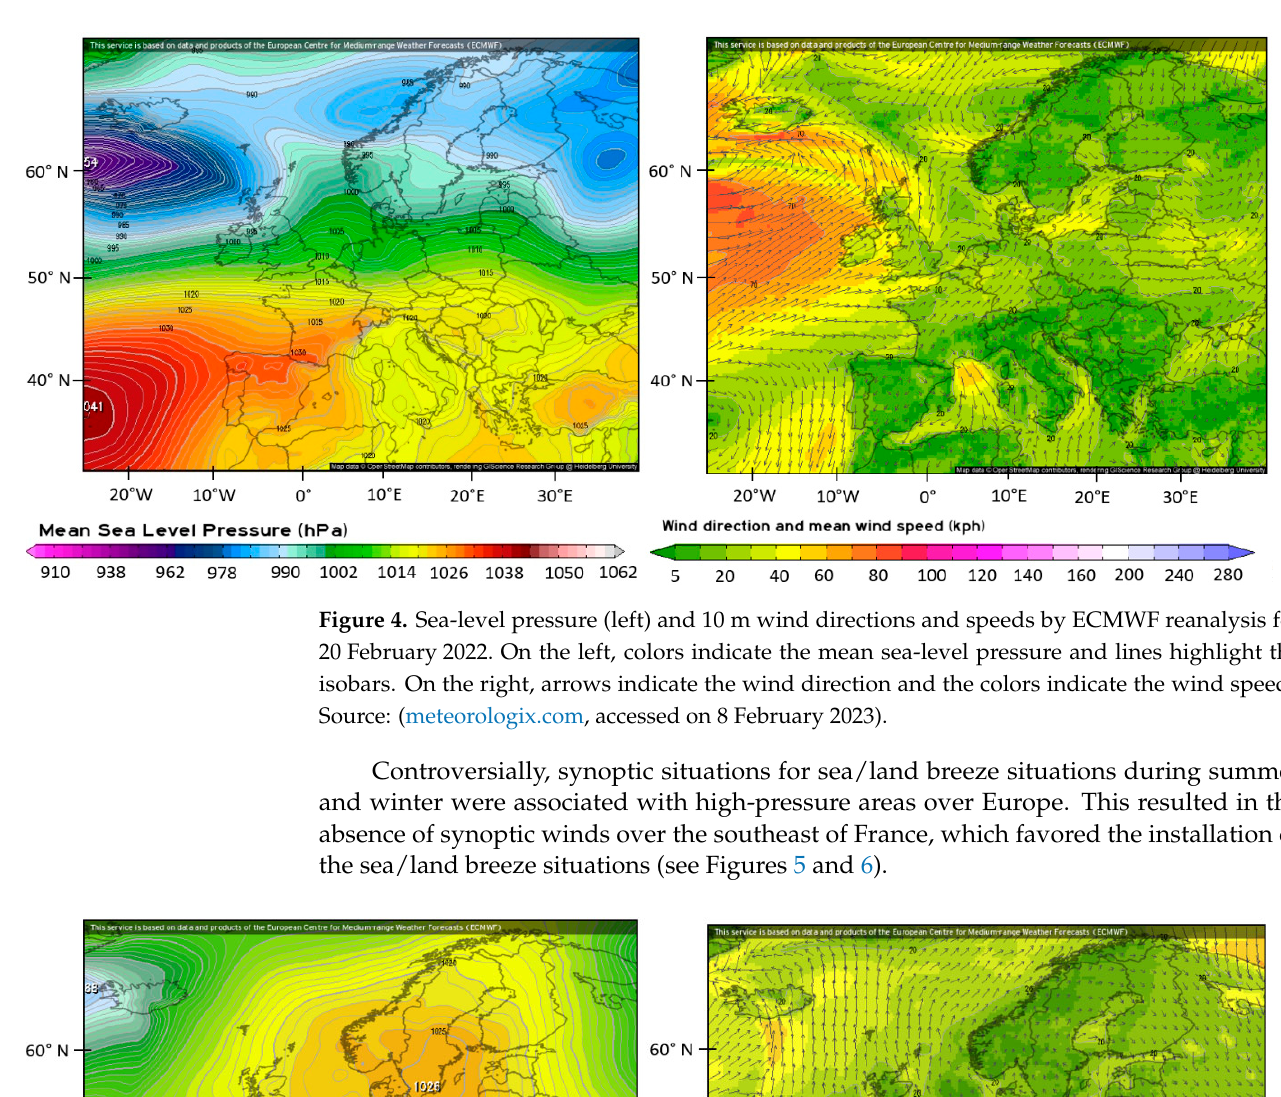
Figure 3. Sea-level pressure (left) and 10 m wind directions and speeds by ECMWF reanalysis for 17 August 2021. On the left, colors indicate the mean sea-level pressure and lines highlight the isobars. On the right, arrows indicate the wind direction and the colors indicate the wind speeds. Source: (meteorologix.com, accessed on 8 February 2023).